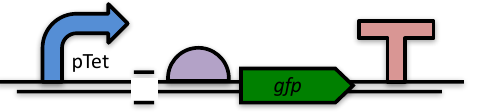
Figure 25: The same functional unit as in Figure 24, with additional assembly-focused information: there is a 5’ overhang before the promoter, a 3’ overhand after the terminator, and an assembly scar between the promoter and the ribosome entry site left over from a prior step of assembly.